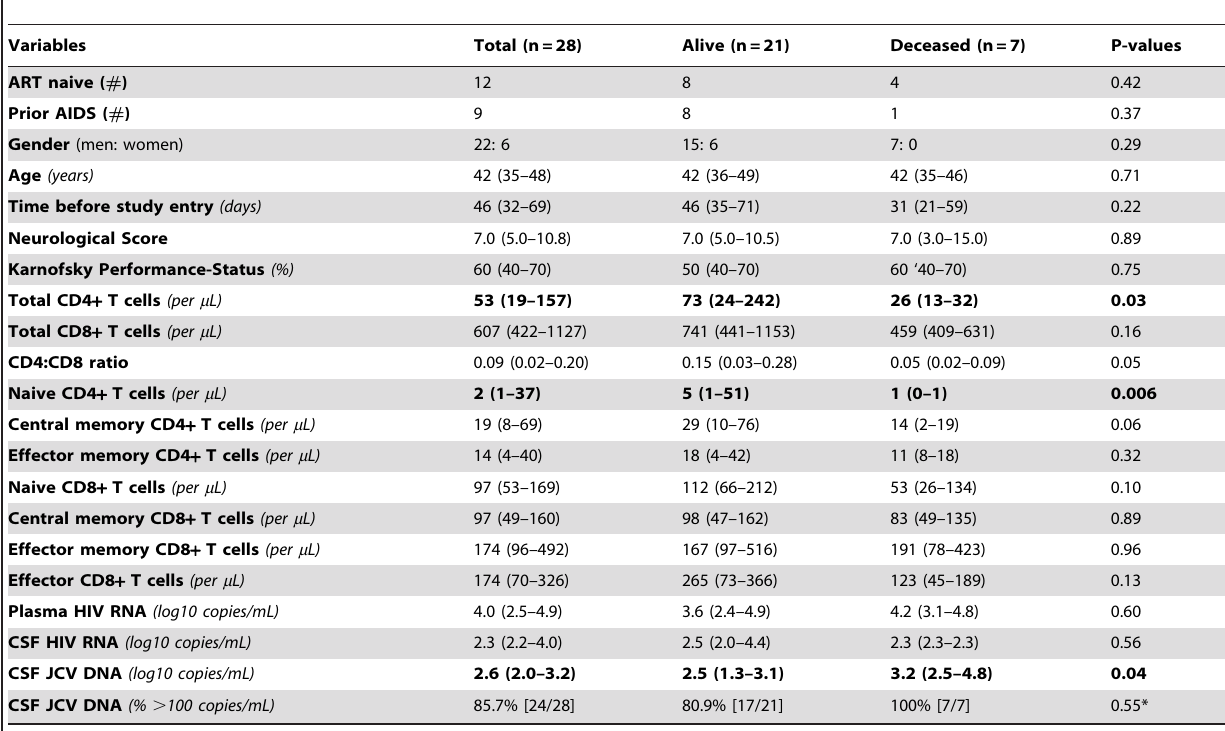
Table 1. Characteristics of patients at enrolment, according to